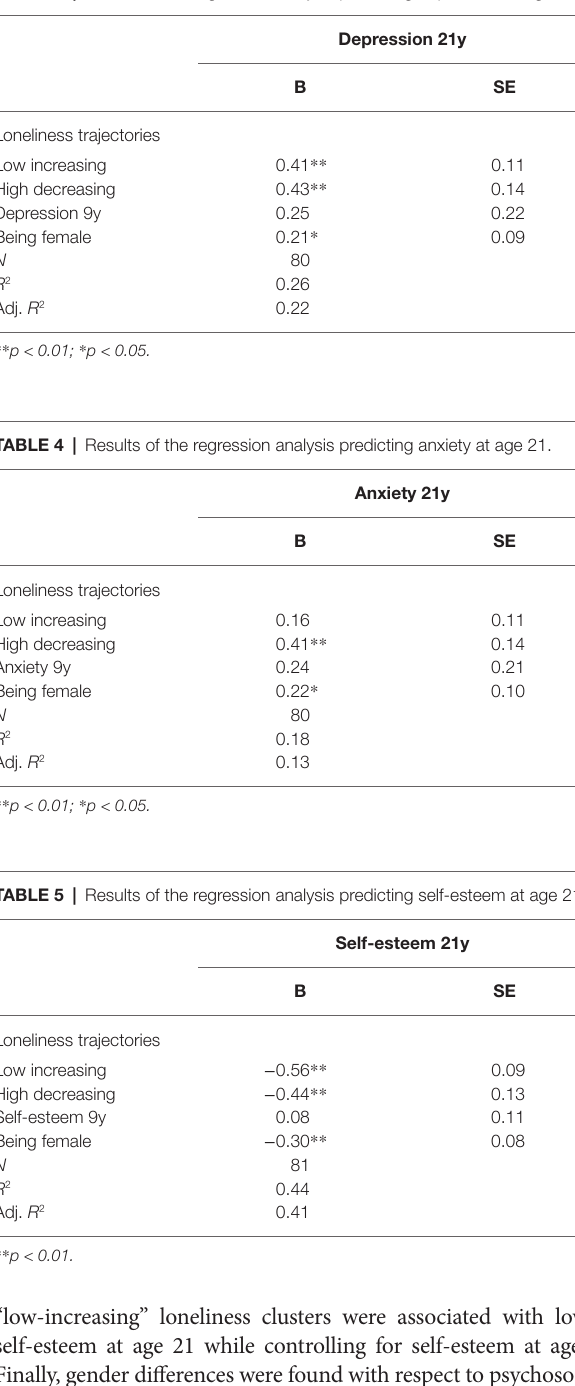
TABLE 3 | Results of the regression analysis predicting depression at age 21.